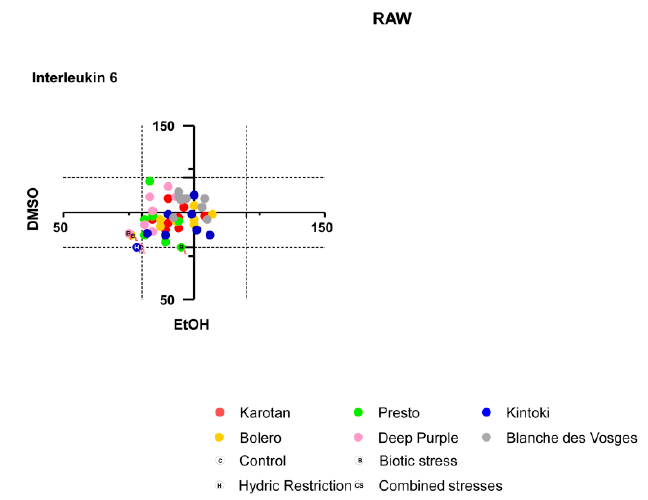
Figure A5. Effect of carrot extracts on macrophages. IL-6 production in Raw 264.7 after treatment with carrot extract from different carrot varieties and growing conditions. In diagram, x-axis and y-axis expressed percentage response values of ethanol and DMSO extracts, respectively. Variations of less than 20% of responses (included in dot lines) were not considered biologically significant.